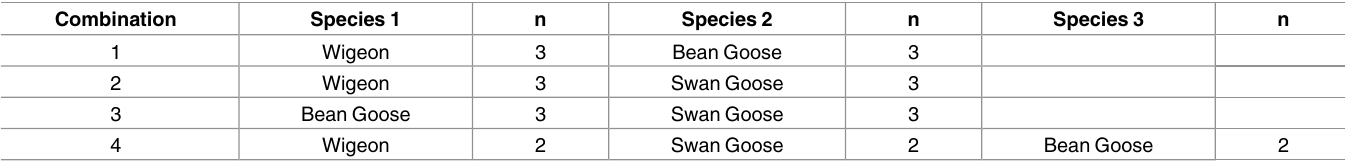
Table 1. All species combinations used in the inter-specific competition experiment. n = number of individuals participating within the combination.